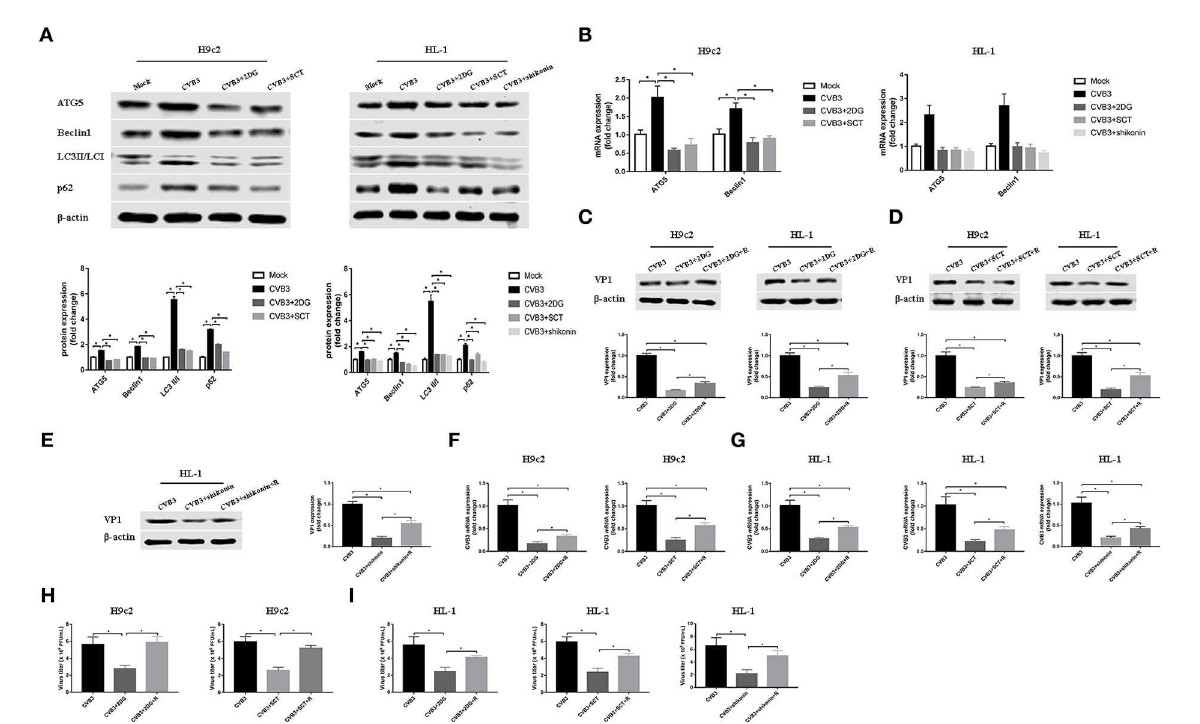
FIGURE4 Coxsackievirus B3 replication is enhanced by activating autophagy. H9c2 cells were divided into four groups: a mock-infected group, coxsackievirus B3 (CVB3)-infected group, CVB3-infected group treated with 2-deoxy-D-glucose, and CVB3-infected group treated with sodium citrate. HL-1 cells were divided into five groups: a mock-infected group, CVB3-infected group, CVB3-infected group treated with 2-deoxy-D-glucose, CVB3-infected group treated with sodium citrate, and CVB3-infected group treated with shikonin, and cells were harvested at 24h post-infection. ATG5, Beclin1, LC3 II,/I, and p62 were measured by Western blotting (A) , and ATG5 and Beclin1 were further measured using quantitative PCR (B) . Subsequently, cells were infected with CVB3 at a multiplicity of infection of 10 and treated with glycolysis inhibitors, with or without rapamycin (100nM), and cells were harvested at 24h post-infection. VP1 levels were measured by Western blotting (C–E) , and CVB3 RNA levels were measured by quantitative PCR (F,G) . Cell supernatant was harvested at 24h post-infection, and CVB3 viral titer levels were measured by plaque-forming unit assay (H,I) . R, rapamycin. Data are indicated as mean ± SEM; data represent three independent experiments with three technical replicates per experiment; * P <